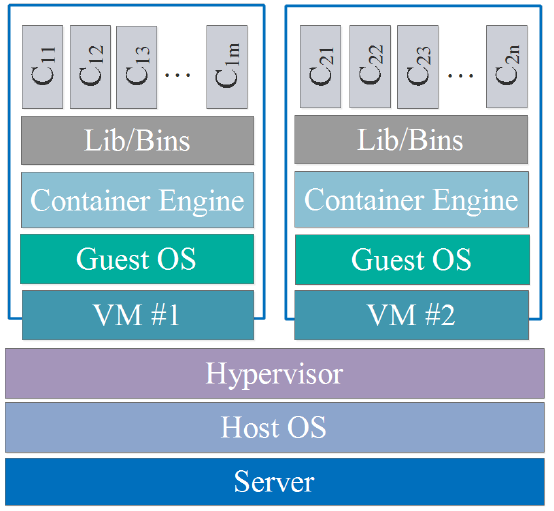
Figure 2. Container as a Service